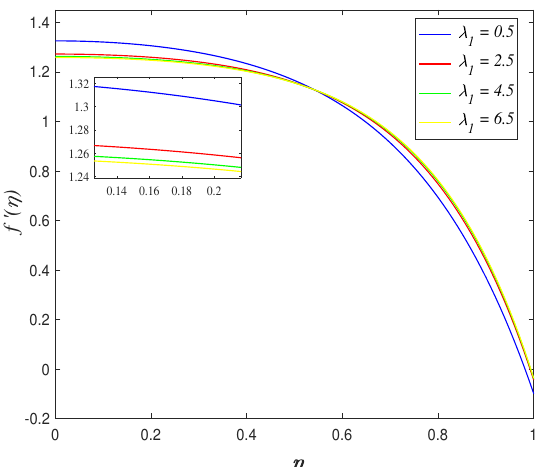
Figure 7. Impact of λ 1 on axial velocity.